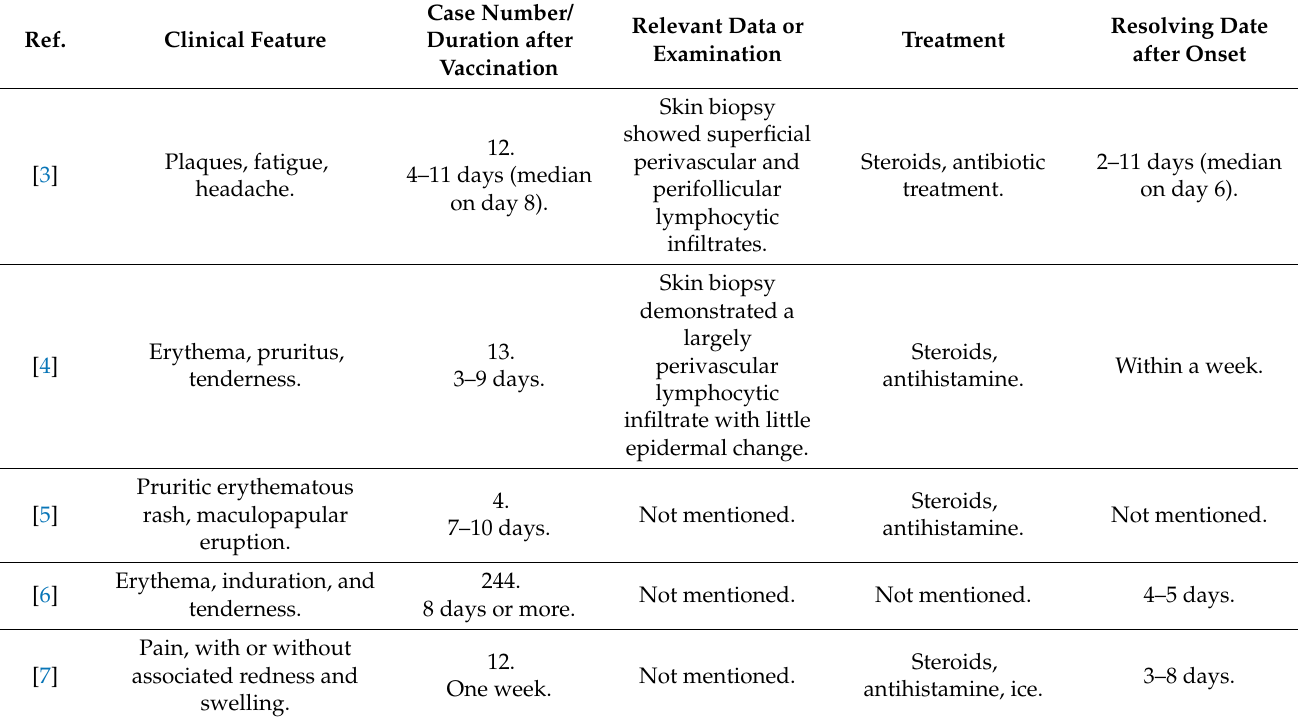
Table 2. Literature reviews of COVID-19 mRNA-1273 vaccine-induced delayed skin reactions.